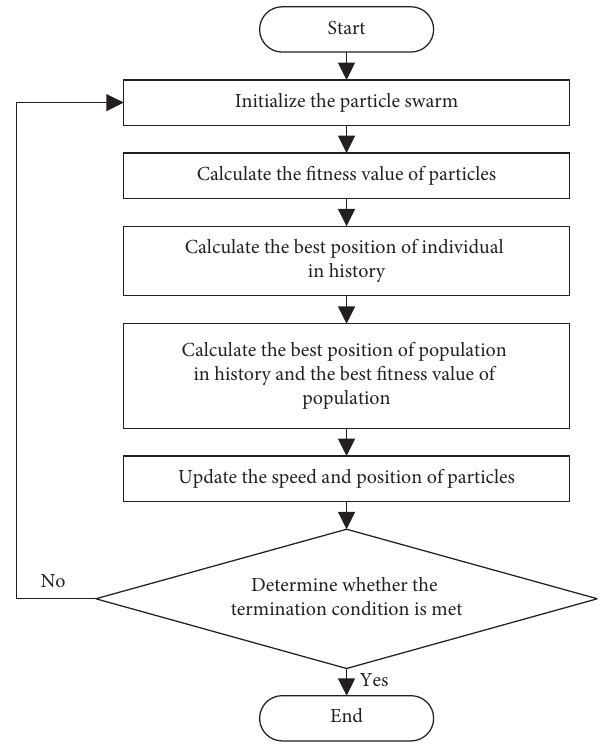
Figure 7: Particle swarm optimization flowchart.